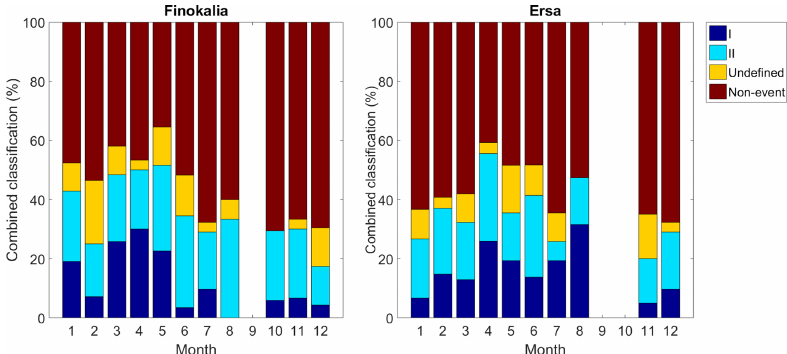
Figure 3. Monthly classification of the measurement days into event (I and II), undefined, and non-event categories in Finokalia and